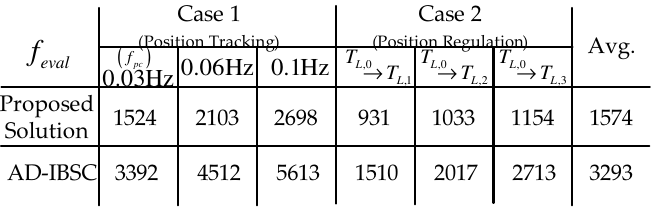
Figure 10. Numerical comparison